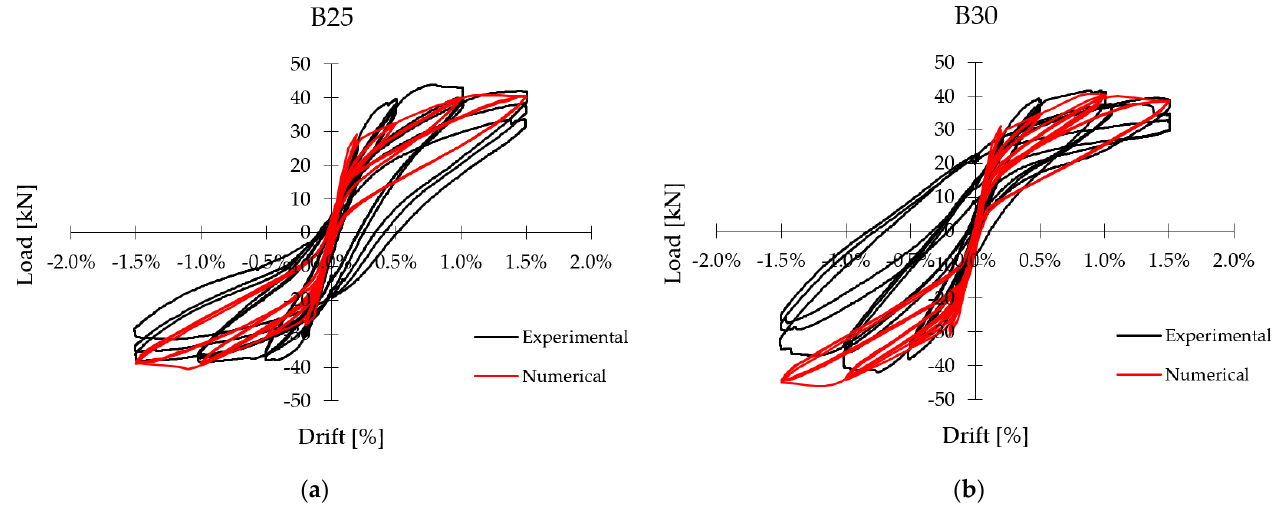
Figure 13. Comparison between experimental and numerical response, corroded specimens, MS 1. ( a ) column B25, ( b ) column B30.